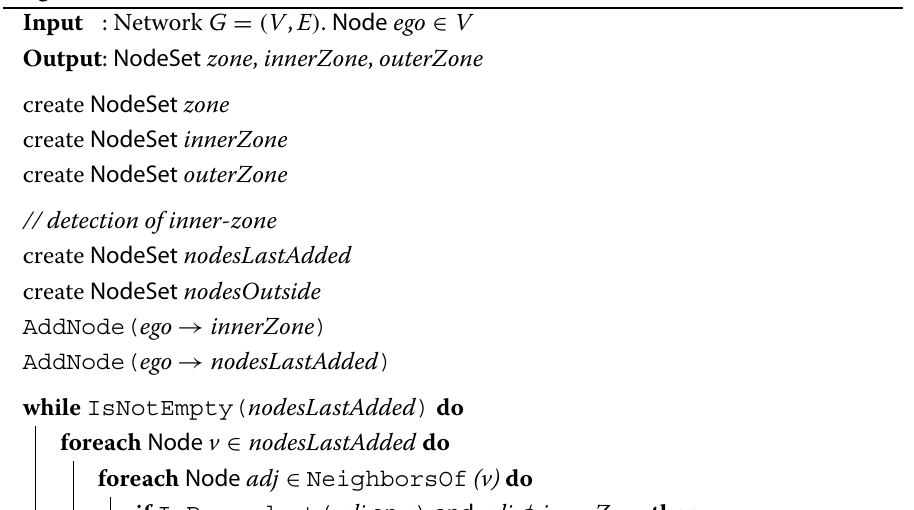
Algorithm 1: Zone